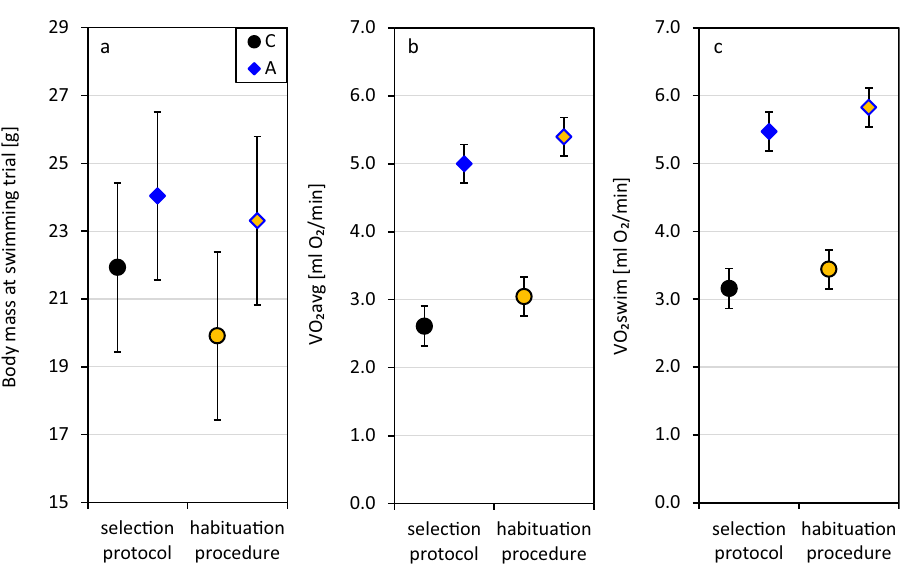
Figure 2. Effects of selection and habituation procedure on body mass and swim-induced rate of oxygen consumption (average: VO 2 avg, and 1-min maximum: VO 2 swim) in bank voles from “control” (C) and “aerobic” (A) lines. The swimming trial was performed on 1026 animals as a part of a selection procedure, and on 100 animals at the conclusion of a three-week habituation procedure. Adjusted least squares means (LSM) and 95% confidence half-intervals (CI) for the metabolic rates were calculated for average (22.4 g) body